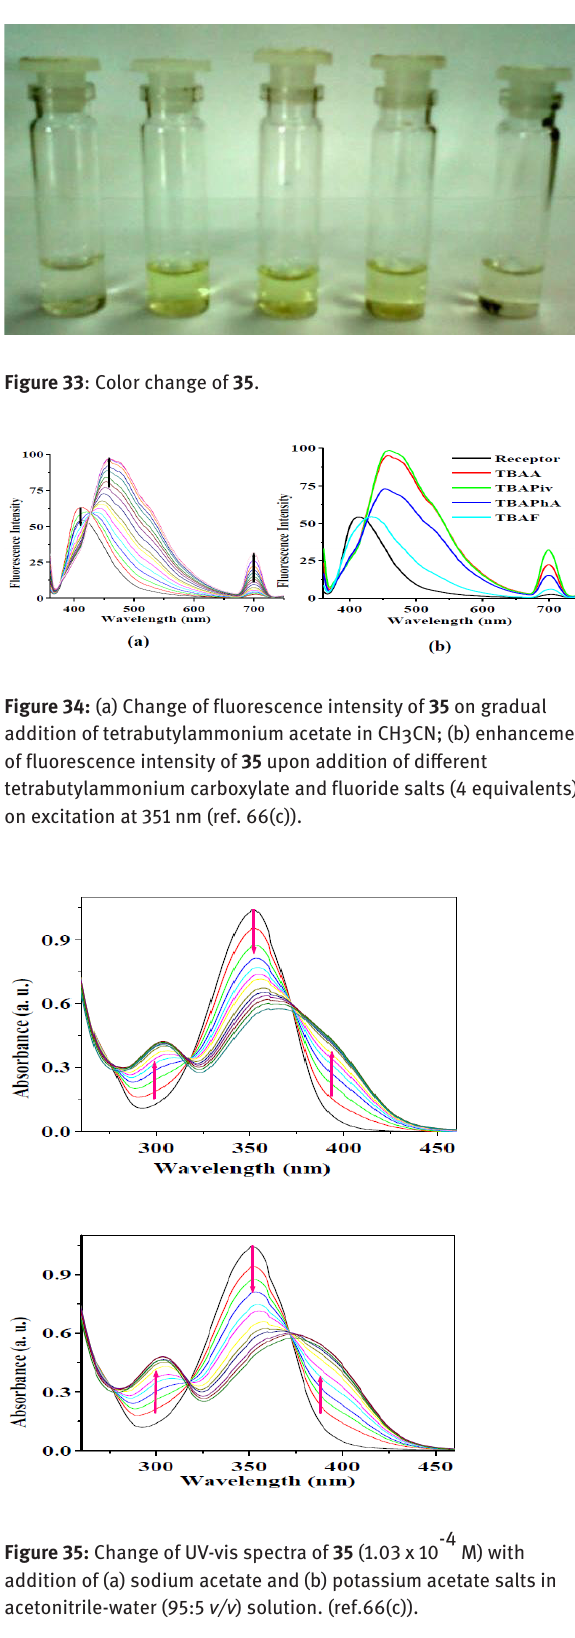
Figure 35: Change of UV-vis spectra of 35 (1.03 x addition of (a) sodium acetate and (b) potassium acetate salts in acetonitrile-water (95:5 v/v ) solution.